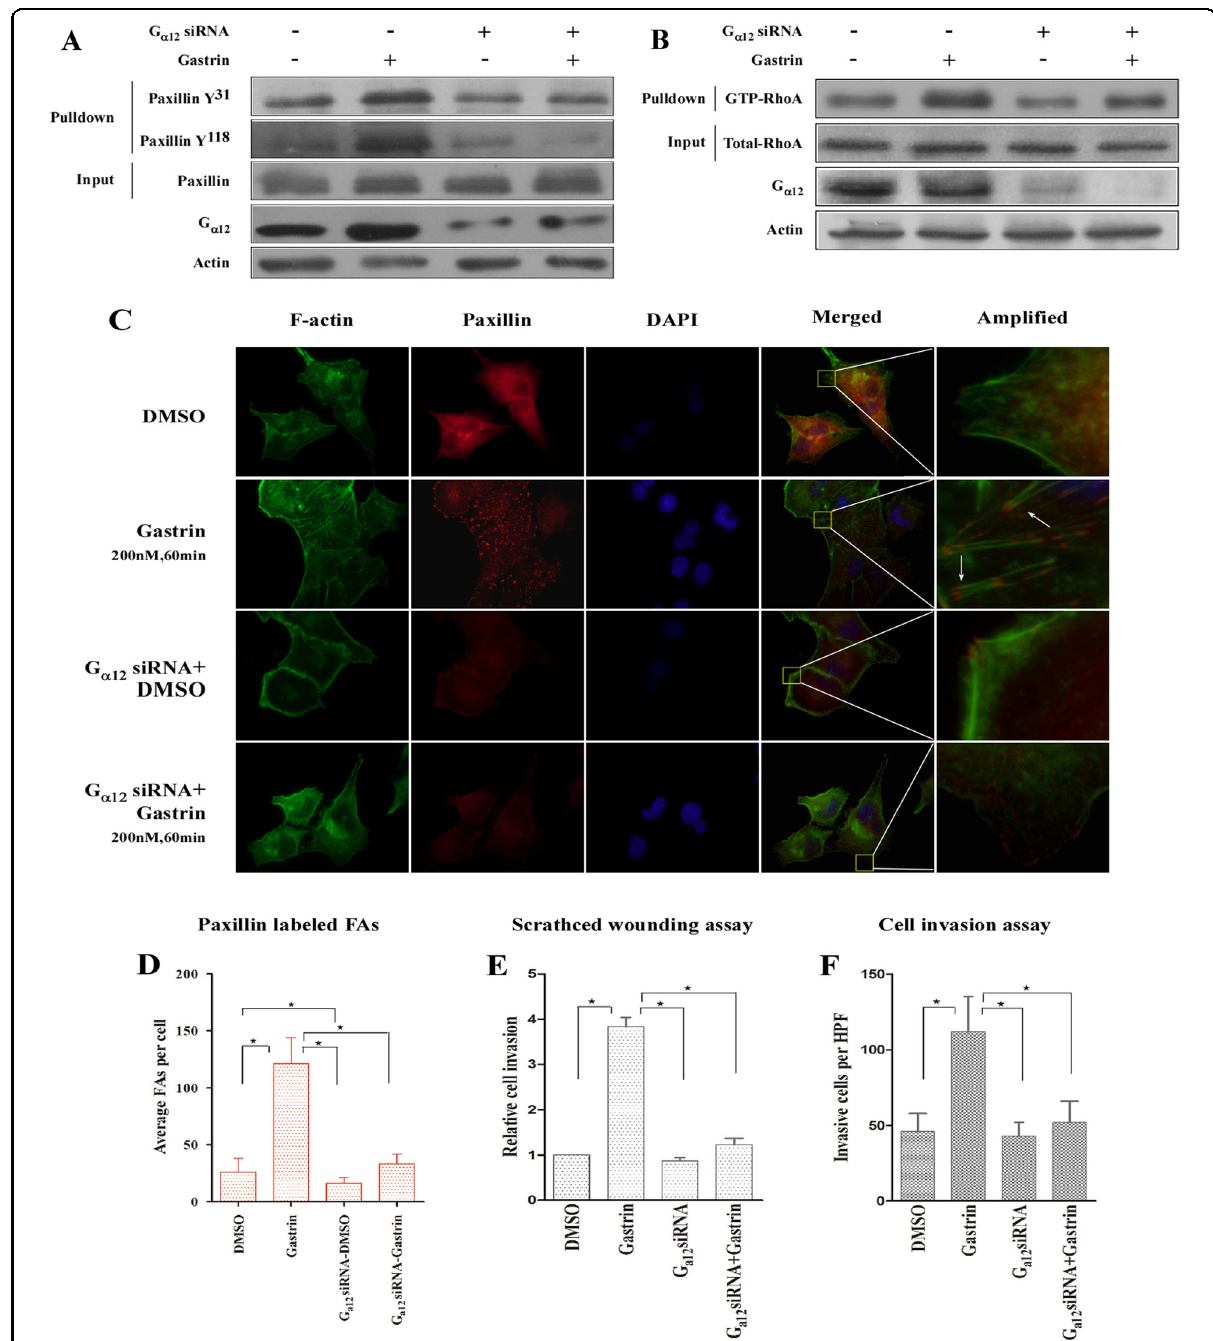
Fig. 2 Gastrin regulates the focal adhesion (FA) formation, F-actin polarization, and migration of PANC-1 cells through the G α 12 pathway. PANC-1 cells were treated with control or G α 12 siRNA as indicated. a As indicated by immunoprecipitation experiments, RNAi-mediated G α 12 protein depletion signi fi cantly suppressed the phosphorylation of paxillin activated by gastrin in PANC-1 cells. b RNAi-mediated G α 12 protein depletion also restrained PANC-1 cells from the elevated GTP-RhoA level that was activated by gastrin. c , d Focal adhesion formation and F-actin polarization were evaluated by immuno fl uorescence ( c ) and were represented by the average number of focal adhesions that were labeled by paxillin per cell ( d ). White arrows show the focal adhesion formation and aggregation at the leading edge of the cells. e , f The scratched wound healing assay ( e ) and Boyden invasion assay ( f ) were conducted to show the migration and invasion of PANC-1 cells. The average number of focal adhesions from a minimum of 20 cells was quanti fi ed. The other values indicate the means ± SD from three independent experiments. * P <